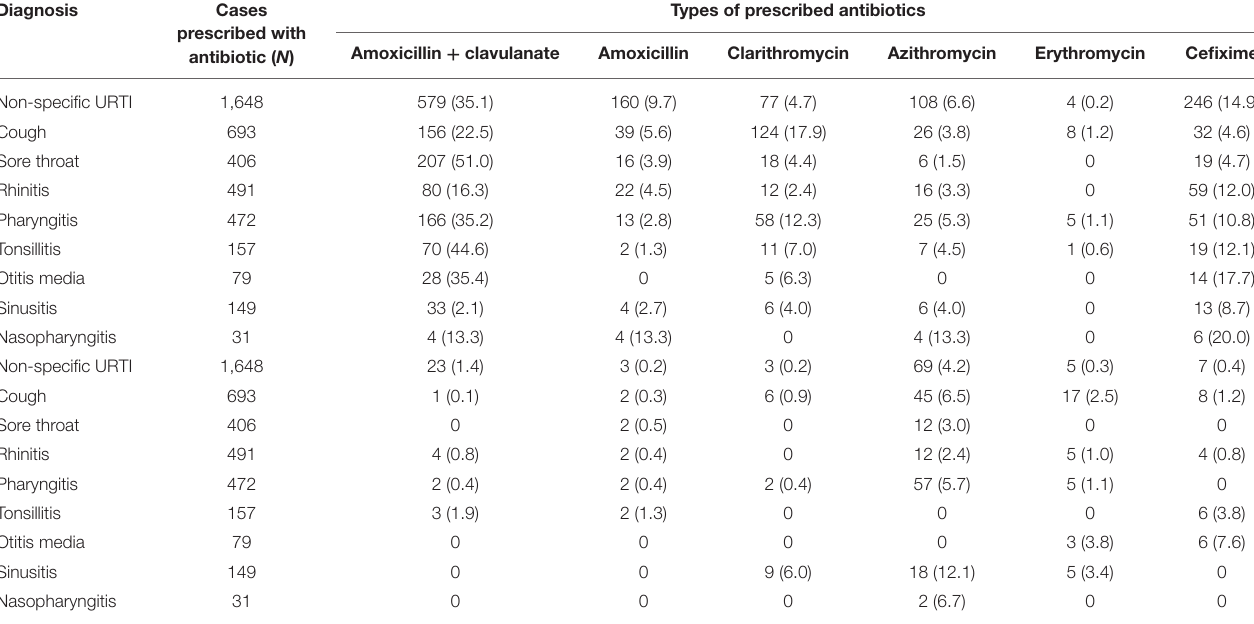
TABLE 3 | Antibiotic prescription against specific diagnosis.